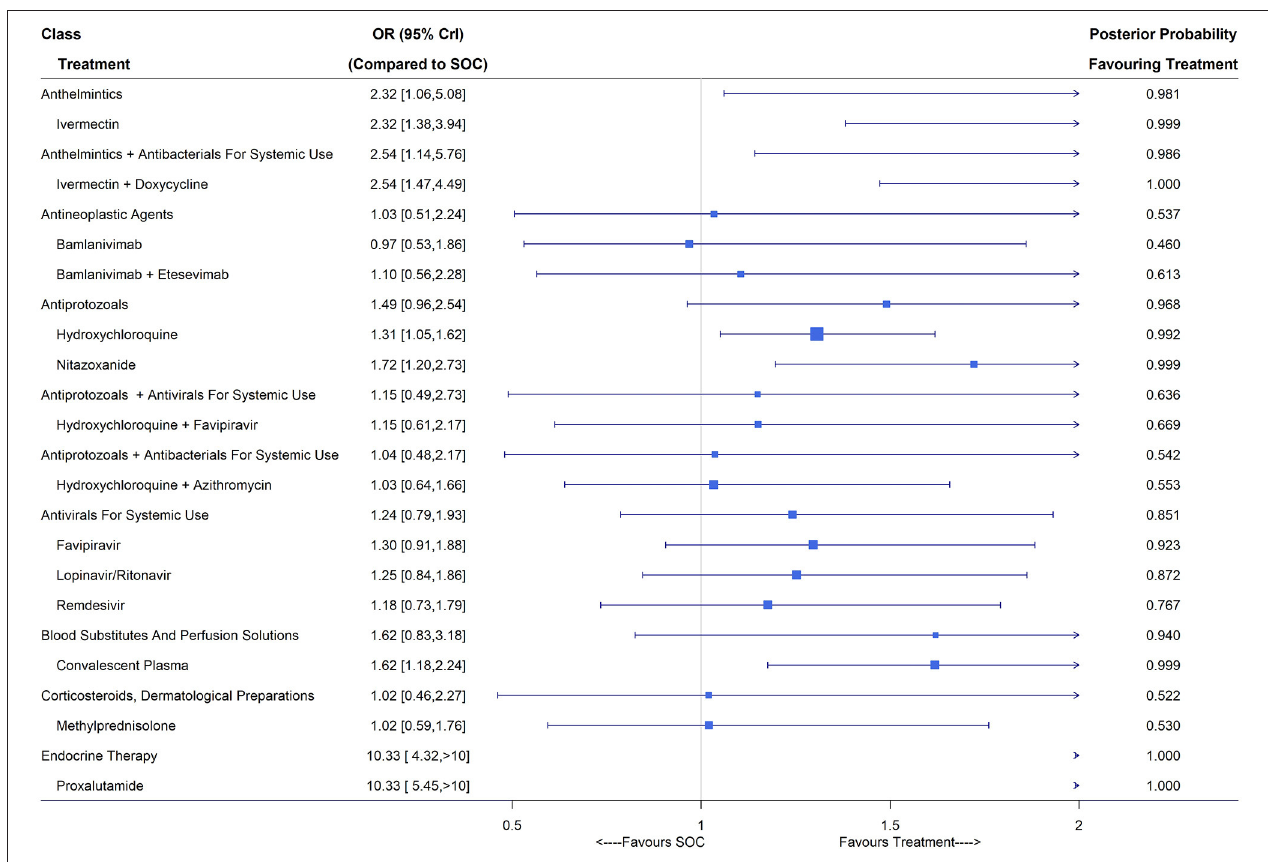
FIGURE 5 | Viral clearance (closest to 7 days) of treatments compared with the standard of care (SOC); OR is the odds ratio and CrI represents the credible